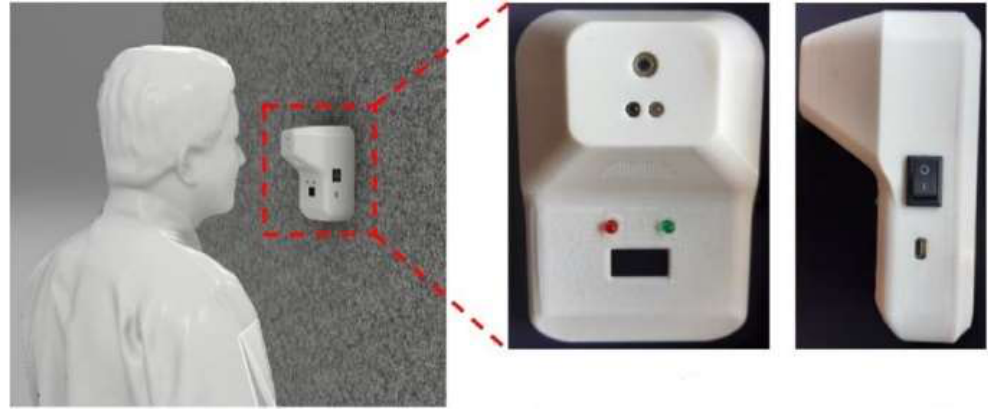
Figure 11. The 3D-printed infrared thermometer (i-Thermowall) [77]; open access.